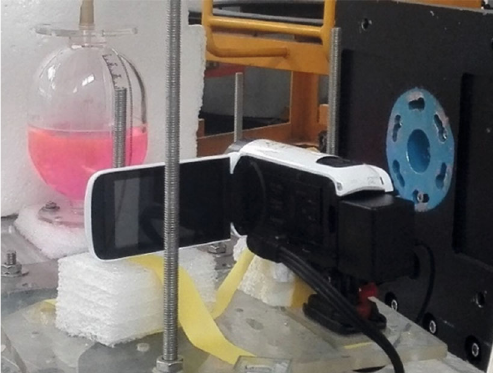
Figure 5: Camera for the measurement